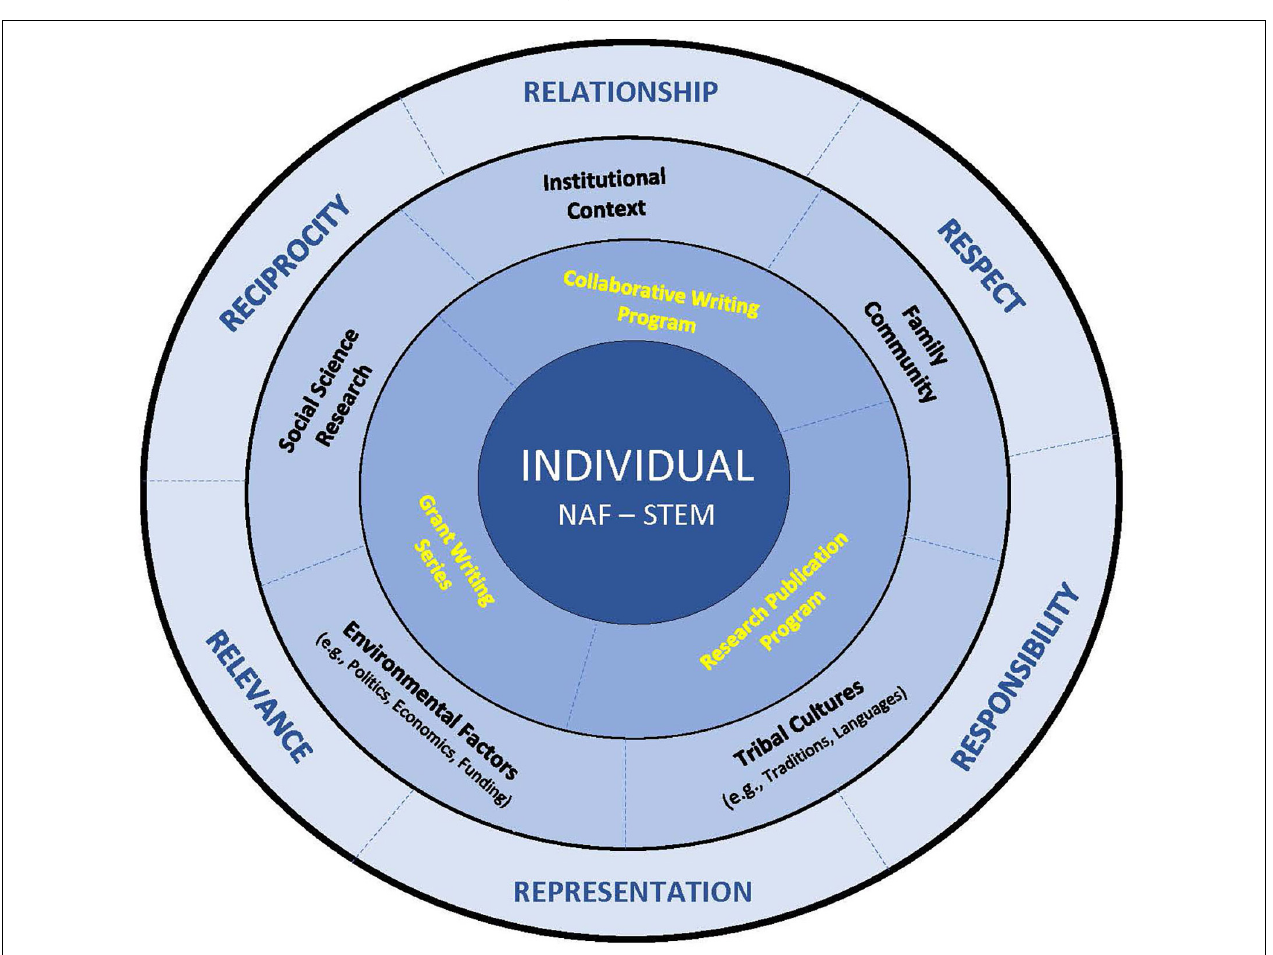
FIGURE 1 | Six R’s indigenous framework for